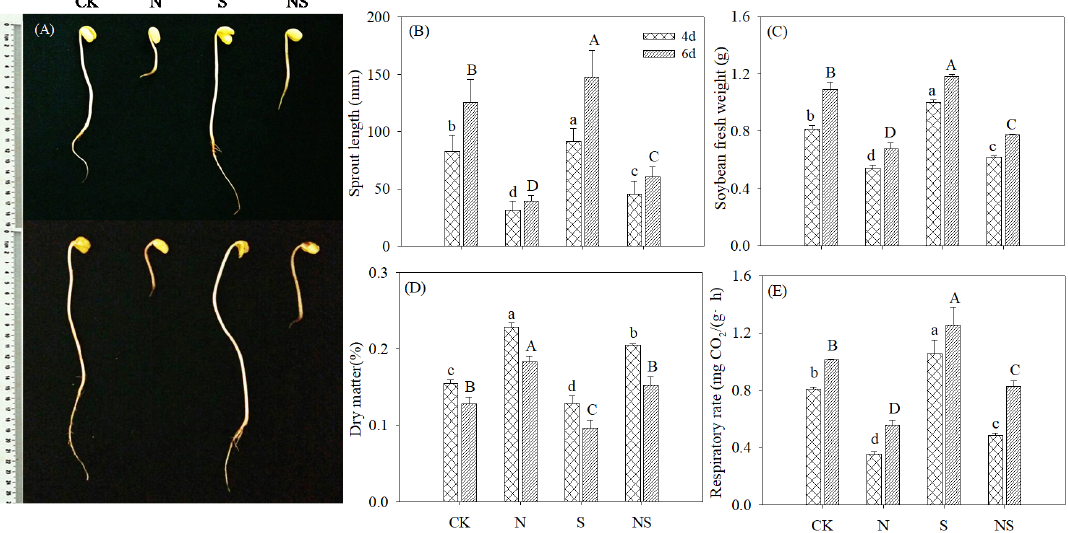
Figure 1. Changing patterns in a ( A ) photograph in terms of ( B ) sprout length, ( C ) fresh weight, ( D ) dry matter content, and ( E ) respiratory rate in germinating soybeans. Lowercase letters reflect